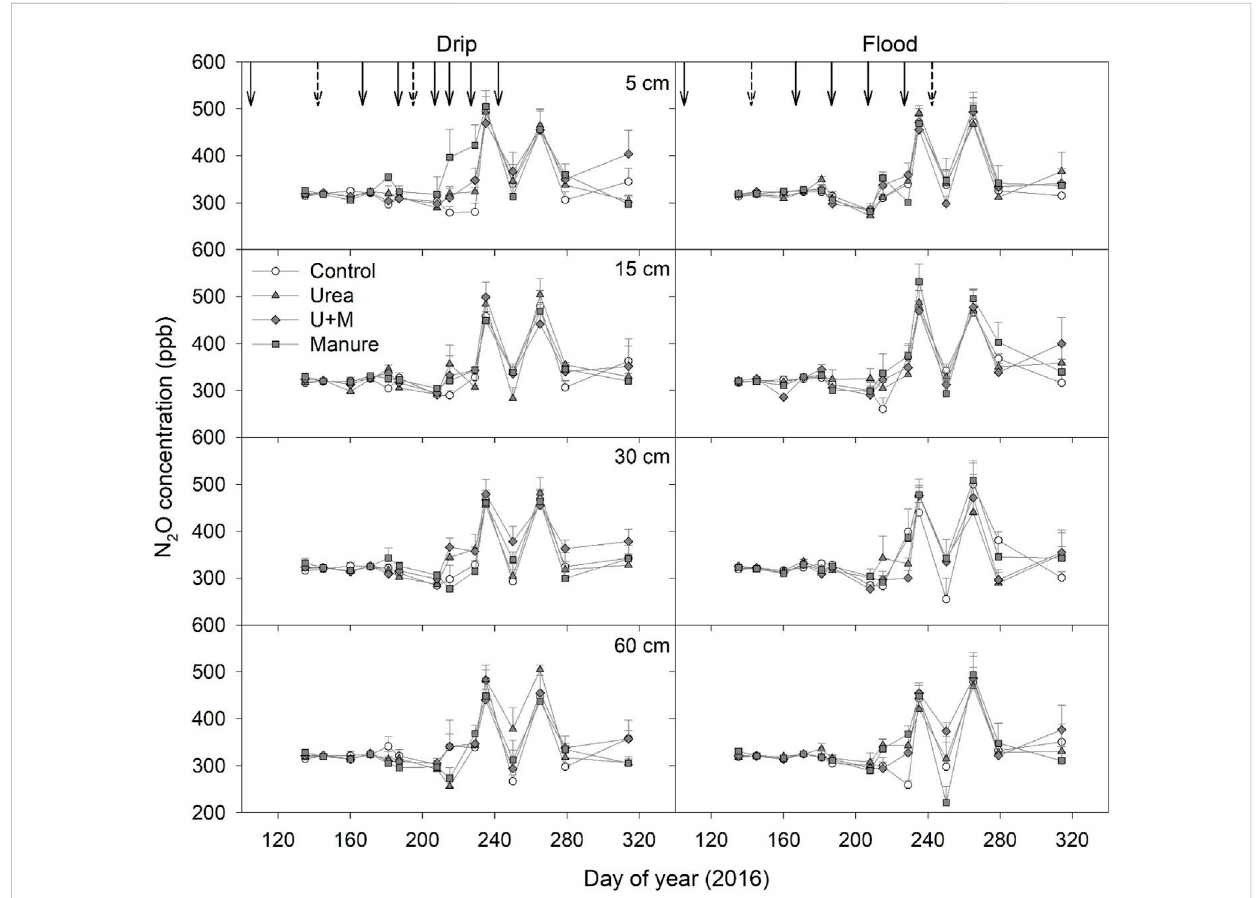
FIGURE 2 N 2 O concentration at each depth as affected by fertilizer treatments under drip and fl ood irrigation. Dashed arrows indicate dates of irrigation only, and solid arrow indicates date of irrigation and urea application. Means +1 standard error ( n = 4) are